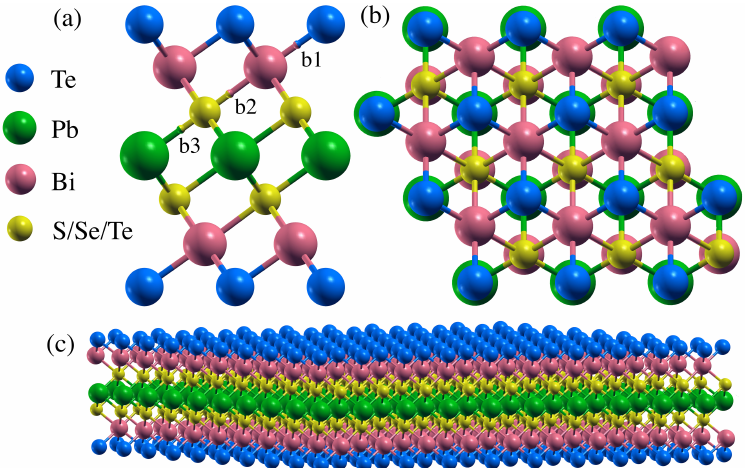
Figure 1. Side view ( a ), top view ( b ) and extended view ( c ) of PbBi 2 Te 2 X 2 (X = S, Se, Te). The three non-equivalent bonds ( b 1– b 3) are shown in ( a